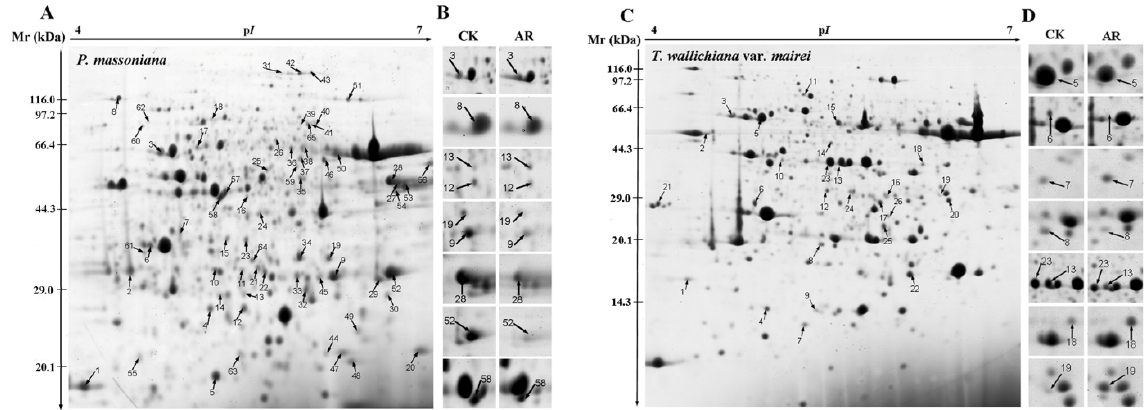
Figure 2. 2-DE image analysis of proteins extracted from P. massoniana and T. wallichinana var. mairei leaves. The numbers assigned to the proteins spots correspond to those listed in Tables 1 and 2. ( A ) A representative Coomassie Brilliant Blue (CBB) R250-stained 2D gel of total soluble proteins from P. massoniana . Arrows indicate 65 spots showing at least 2-fold changes ( p < 0.05) were analyzed by Matrix-assisted laser desorption/ionization-time-of-flight mass spectrometry (MALDI-TOF MS); ( B ) Close-up view of some differentially expressed protein spots in P. massoniana ; ( C ) A representative CBB R250-stained 2D gel of total soluble proteins from T. wallichinana var. mairei . Arrows indicate 26 spots showing at least 2-fold changes ( p < 0.05) were analyzed by MALDI-TOF MS; ( D ) Close-up view of some differentially expressed protein spots in T. wallichinana var. mairei